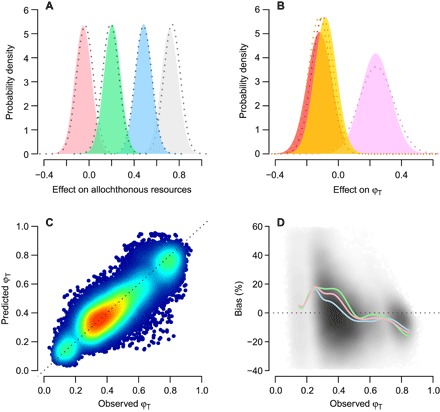
Model recovers known parameters across 100 simulated data sets that replicate our empirical observations.Mean posterior distributions of the effects of (A) DOC (gray), normalized difference vegetation index (NDVI) (pink), ratio of lake perimeter to area (blue), and area of woody vegetation per meter shoreline (green) on availability of allochthonous resources and (B) allochthonous resources (purple), lake chlorophyll a (red), and an allochthonous resources–chlorophyll a interaction (orange) on terrestrial resource use (ϕT); dashed lines are known prior distributions. (C) Mean predicted ϕT versus observed (that is, known) ϕT for 559 consumer observations in each of the 100 simulations. Warmer colors indicate greater concentration of points (total n = 55,900). (D) Percent bias in mean predicted ϕT values. Darker shading indicates greater concentration of points. Lines are splines fitted through observations on one (δ2H only; pink), two (δ13C-δ15N; green), or three (δ13C-δ15N-δ2H; blue) isotopes.